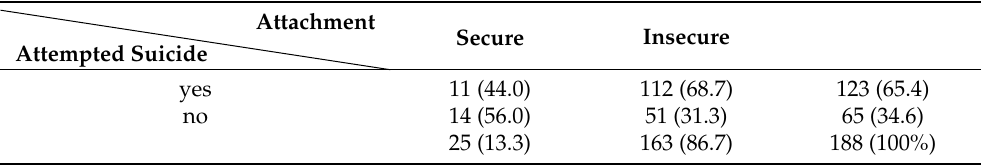
Table 6. Patients admitted to the psychiatric secure unit according to security of attachment to father and lifetime experience of attempting suicide. Data are number of patients (%).